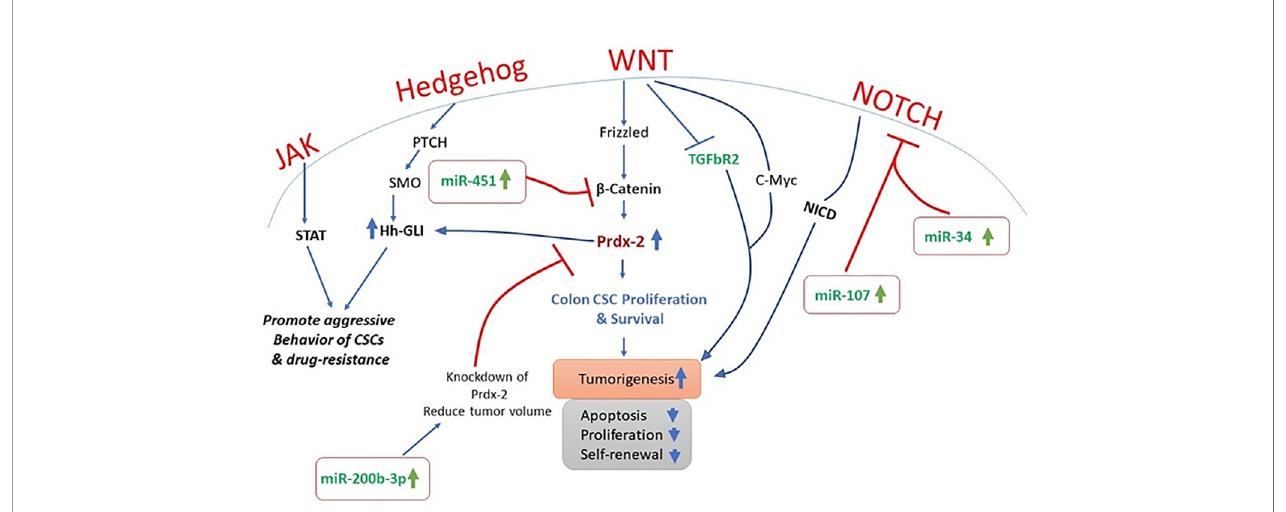
FIGURE 1 | Therapeutic potential of miRNA inhibitors by targeting aberrant signaling